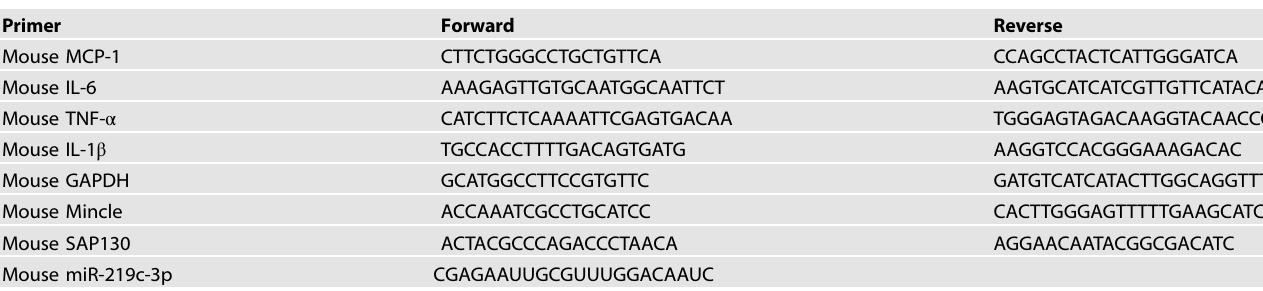
Fig. 6 MiR-219c-3p overexpression ameliorated acute kidney in fl ammation. A Schematic overview of study in AKI model induced by UUO mice with miR-219c-3p overexpression via lentiviral vector transfection. B Expression of miR-219c-3p in the UUO kidney transfected with miR- 219c lentiviral or NC as control. C – D Representative sections of mice kidney stained for F4/80 + macrophages. The number of in fi ltrated macrophages were quanti fi ed. Scale bar, 100 μ m. E – G Mincle, MCP-1, TNF- α was detected by RT-PCR in the kidney which were inhibited by miR-219c-3p overexpression. Data were presented as mean ± SD. * p < 0.05 compared to NC_UUO. NC_UUO, UUO mice treated with empty lentiviral vector as a negative control. MiR-219c lentiviral_UUO, UUO mice treated with miR-219c-3p overexpression via lentiviral transfection. Table 2. Primers of quantitative